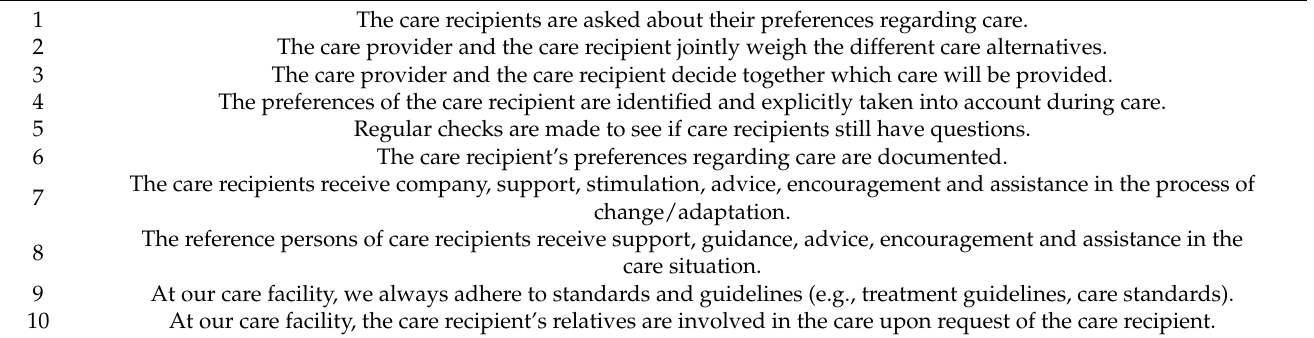
Table 2. Items of the person-centered care (PCC) scale surveyed among leaders of long-term care facilities in Germany during the COVID-19